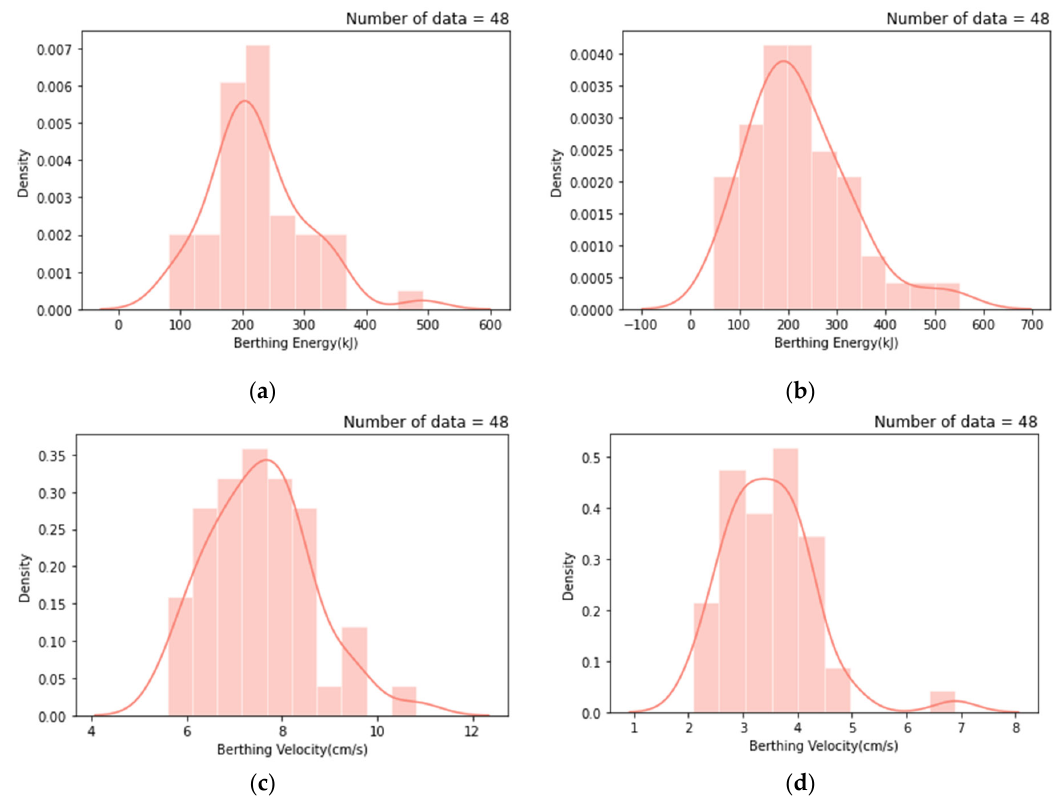
Figure 9. Distribution to confirm the data normality: ( a , b ) histograms of berthing energy mean and standard deviation, respectively; ( c , d ) histograms of berthing velocity mean and standard deviation, respectively. Table 5. Results of the Normality